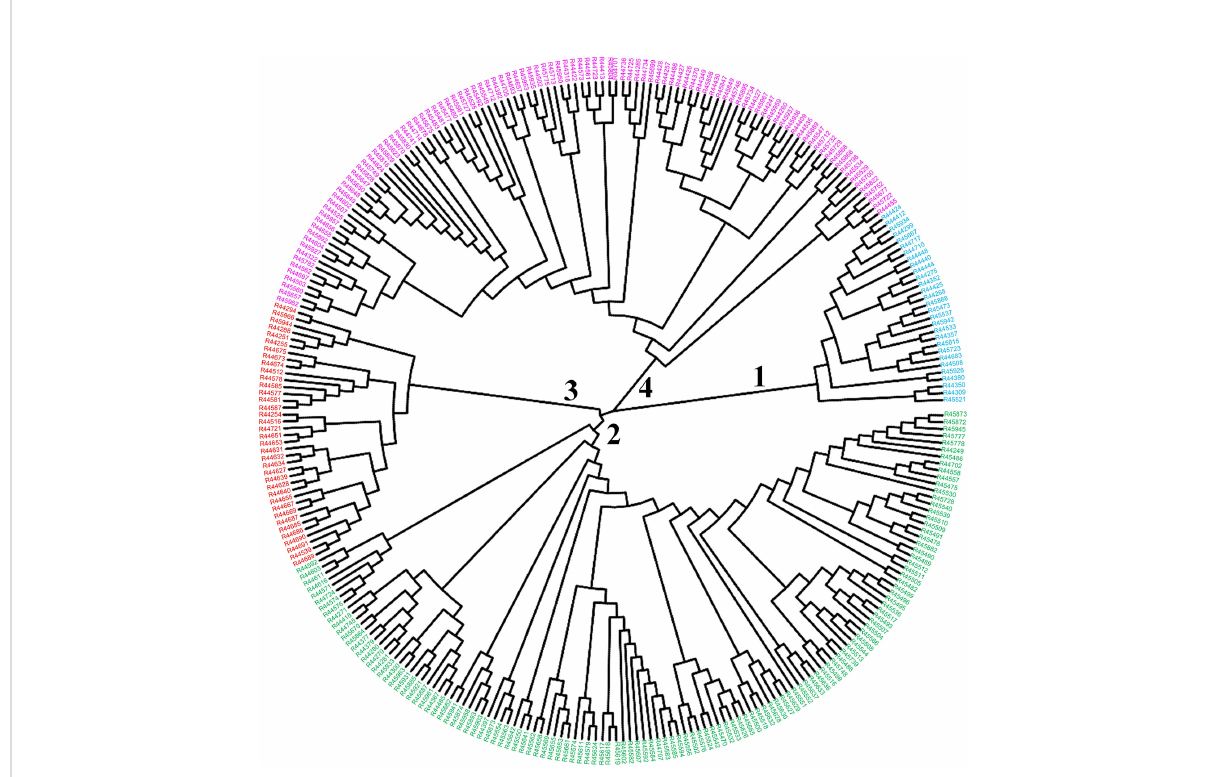
FIGURE 6 Neighbour-joining tree of the core collection of O. ru fi pogon . Colours represent different subpopulations of the core collection; blue colour = subpopulation 1, green = subpopulation 2, red = subpopulation 3, purple = subpopulation